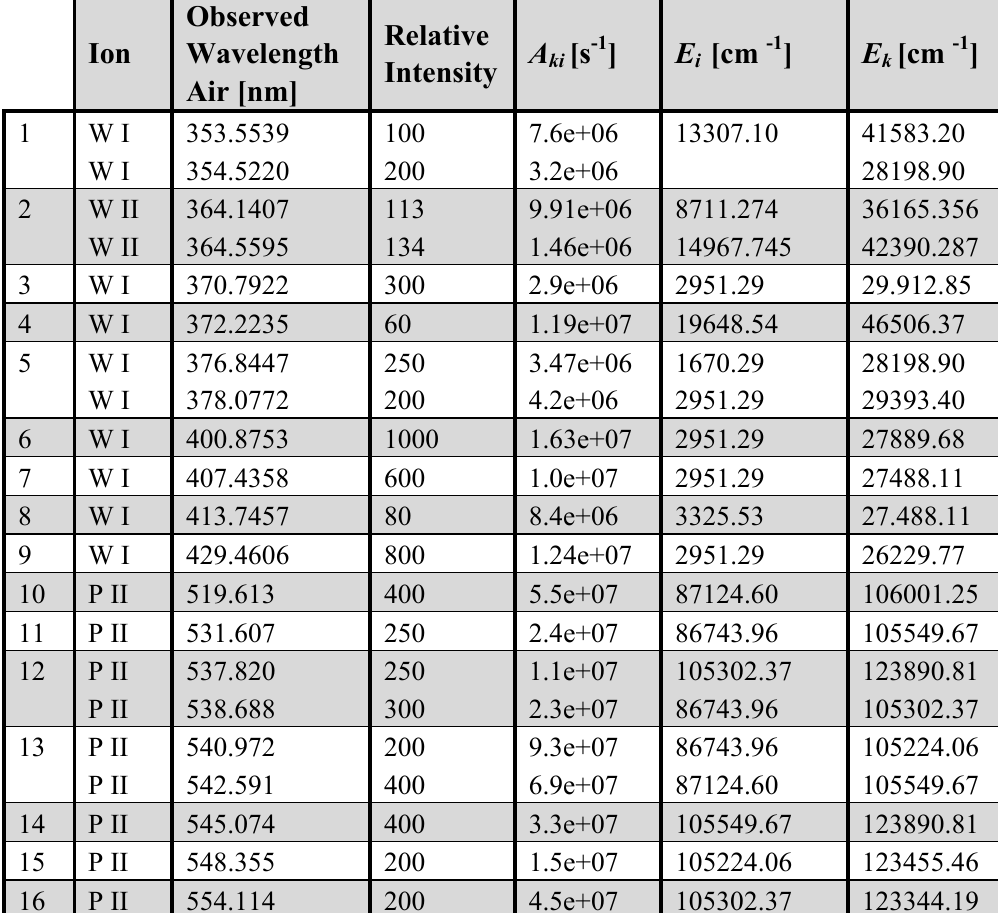
Table 1. Wavelength, transition strength, and relative intensity of atomic and ionic